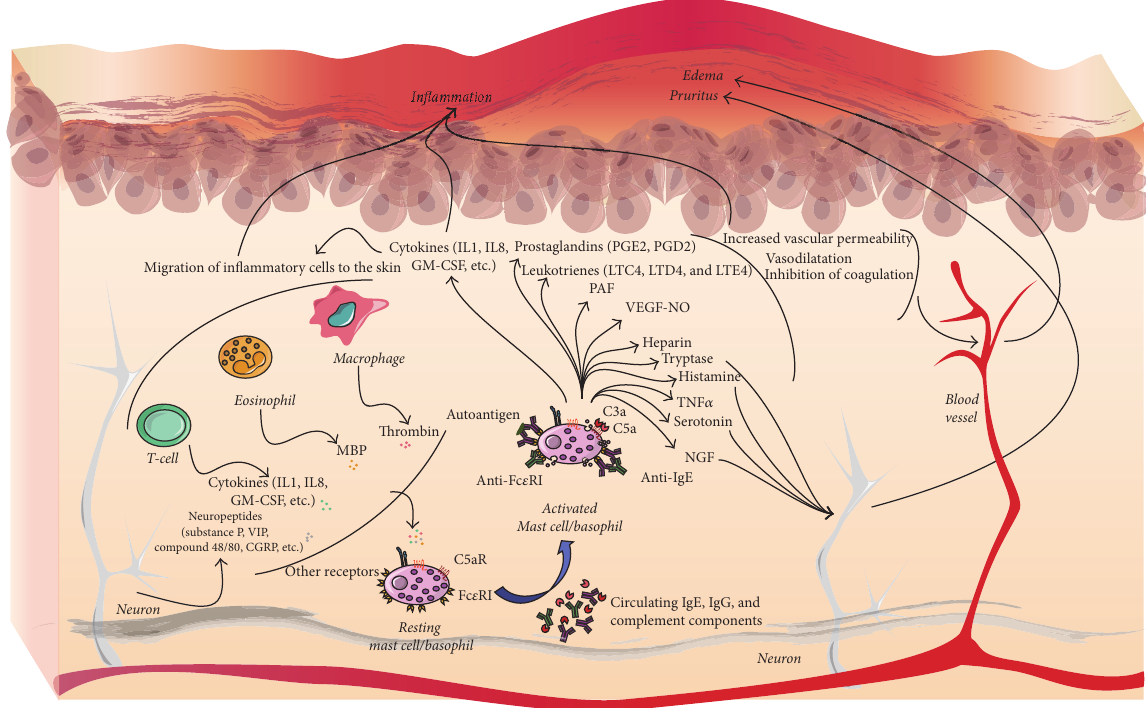
Figure 2: Pathophysiology of urticaria. In CSU patients, stimulation of mast cells (MC) and basophils (BS) can be triggered by IgE against autoantigens, by IgG against Fc 𝜀 RI or IgE against IgE itself, or by complement. Moreover, MC and BS can be stimulated by molecules secreted by other immune cells or neurons. Once activated, MC and BS secrete several preformed mediators, such as histamine or tryptase, and other de novo mediators, such as prostaglandins and leukotrienes, will promote inflammation, vascular permeability, and vasodilatation, as well as neuron stimulation. These effects are transduced into edema and pruritus. Secretion of cytokines by MC and BS triggers migration of other immune cells to the skin, which will contribute to skin inflammation. MBP: major basic protein; NFG: nerve growth factor; PAF: platelet-activating factor; NO: nitric